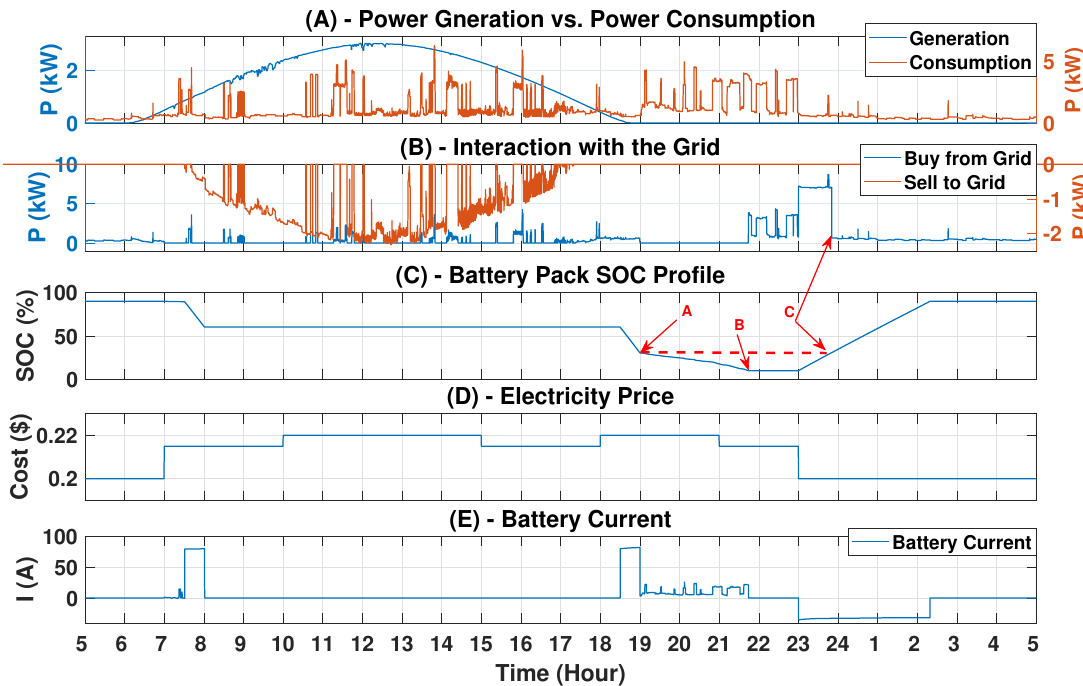
Figure 16. One-day long simulation with power quantities of the EES extracted from Figure